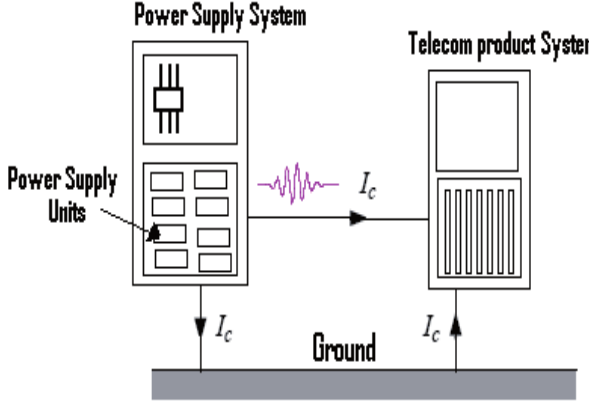
Fig. 1. Common Mode conducted